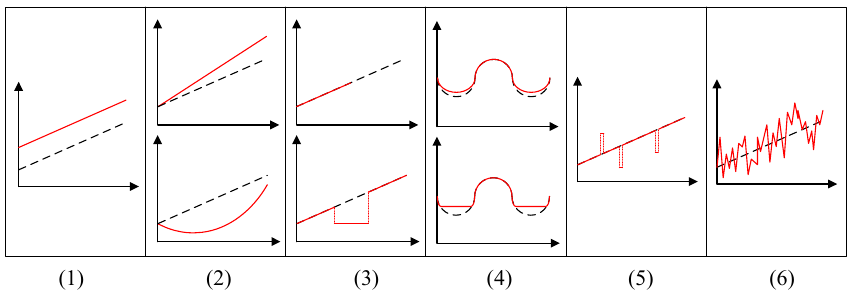
Figure 3. Sensors’ failure modes. The faulty sensor output is represented with a filled line, whereas the real values are depicted with a dashed